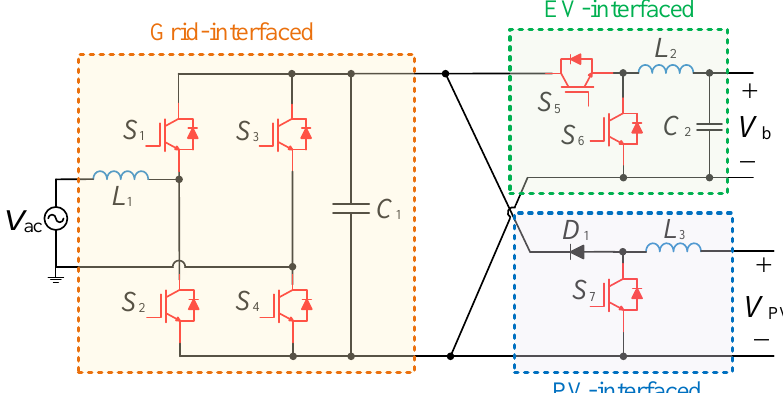
Figure 15. Three-port integrated architecture for EV charging, including a DAB converter to interface the grid and an interleaved Boost converter to interface with EV and PV (Port 3: Grid, port 1: EV, port 2: PV) [89].